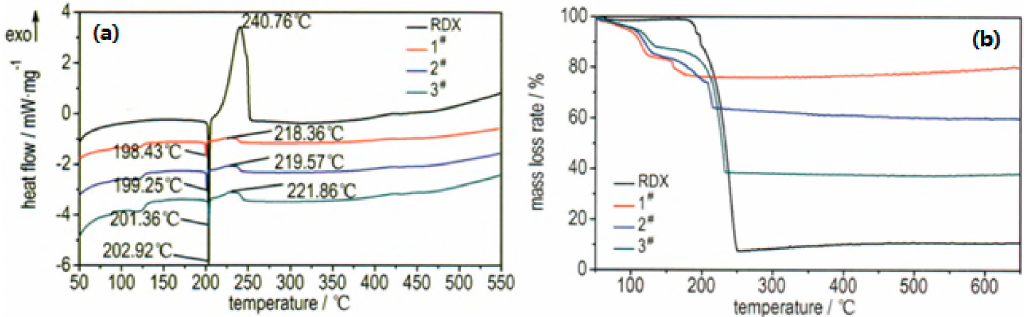
Figure 15. DSC ( a ) and TG ( b ) curves of pure RDX and nano-sized Al / RDX / SiO 2 composite particles. 1# is 30%, 2# is 50%, and 3# is 70%. Reproduced from [53], with permission from Han Neng Cai Liao, 2017.